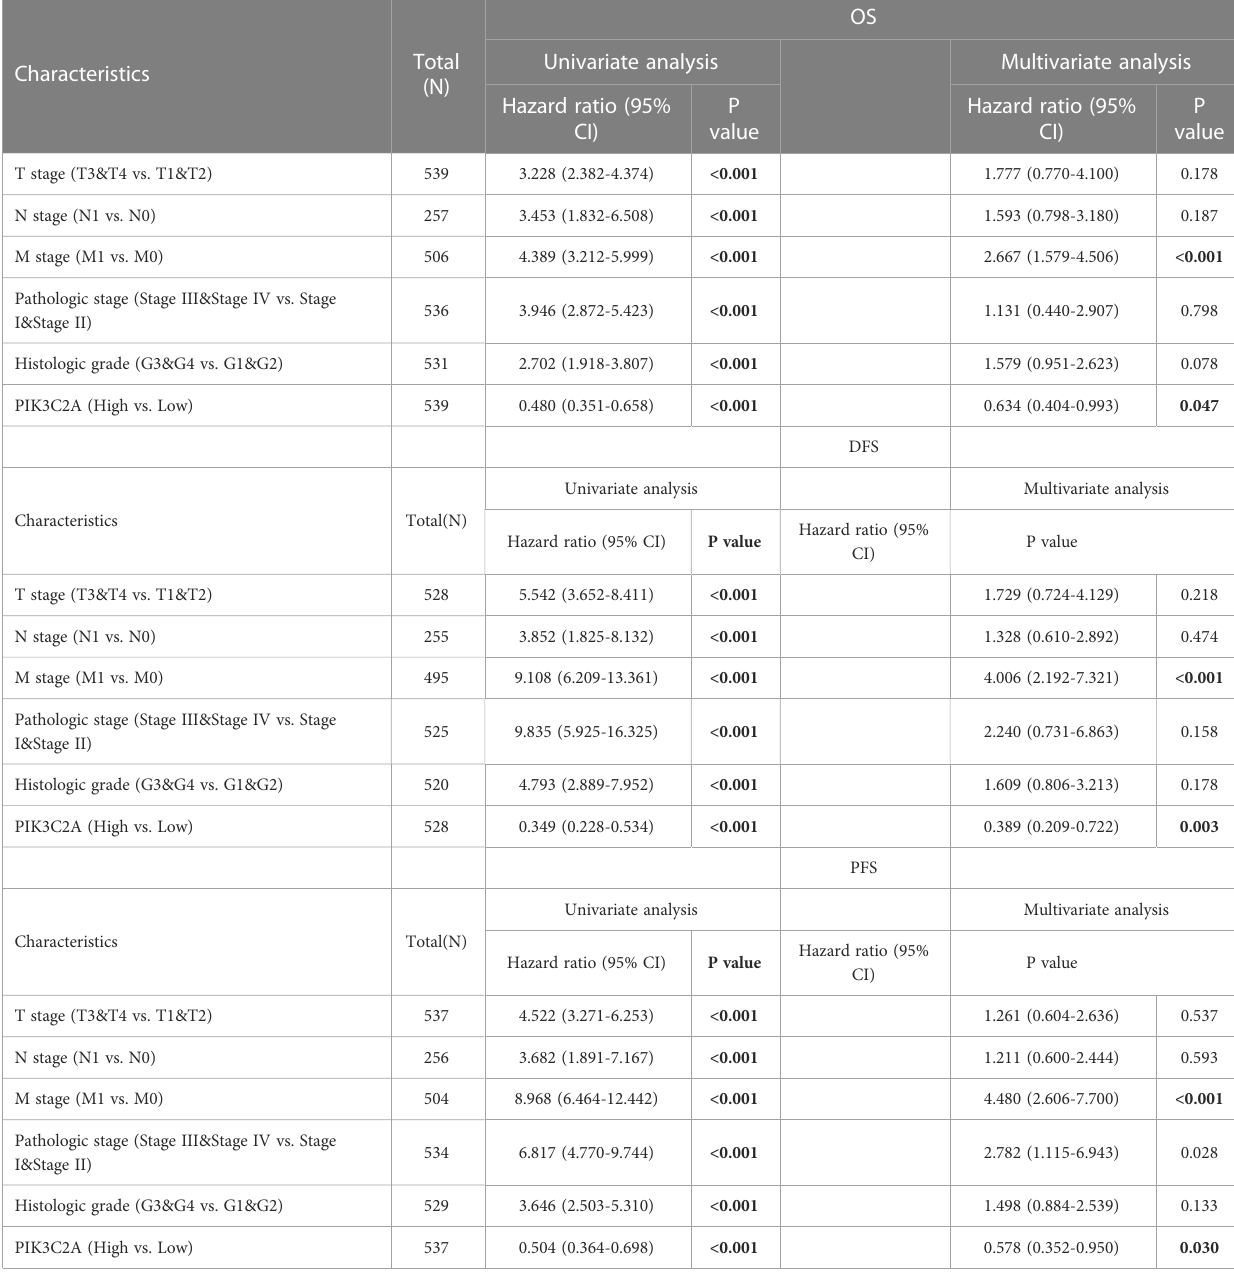
Figure 6D), suggesting that PIK3C2A alterations may contribute to KIRC-related immunological dysfunction. using the CIBERSORT algorithm, we evaluated the correlation between PIK3C2A status and 22 immune fractions, uncovering a widespread immune in fi ltration pattern of KIRC. The results revealed a higher in fi ltration degree of B cell native (adjusted p - value= 6.49E-10), B cell plasma (adjusted p -value=4.88E-02), T cell CD4+ memory resting (adjusted p -value = 8.92E-04), NK cell resting (adjusted p -value= 1.29E-02), Monocyte (adjusted p - value= 3.91E-08), Macrophage M1 (adjusted p -value= 1.69E-02), Macrophage M2 (adjusted p -value=4.64E-04), Myeloid dendritic cell resting (adjusted p -value= 3.84E-02), Mast cell activated